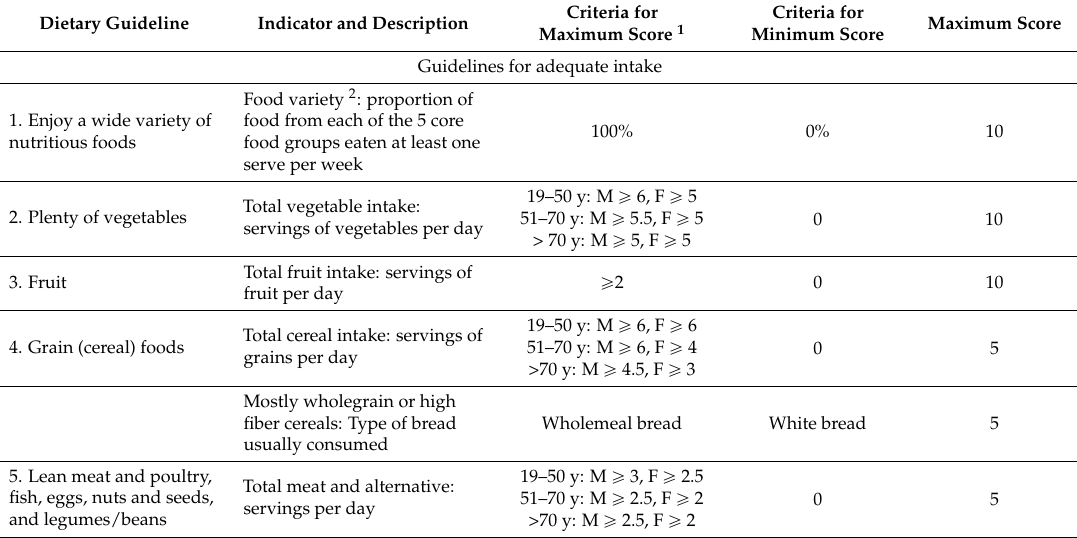
Table 1. Components and scoring methods of the revised Dietary Guideline Index (DGI-2013). Dietary